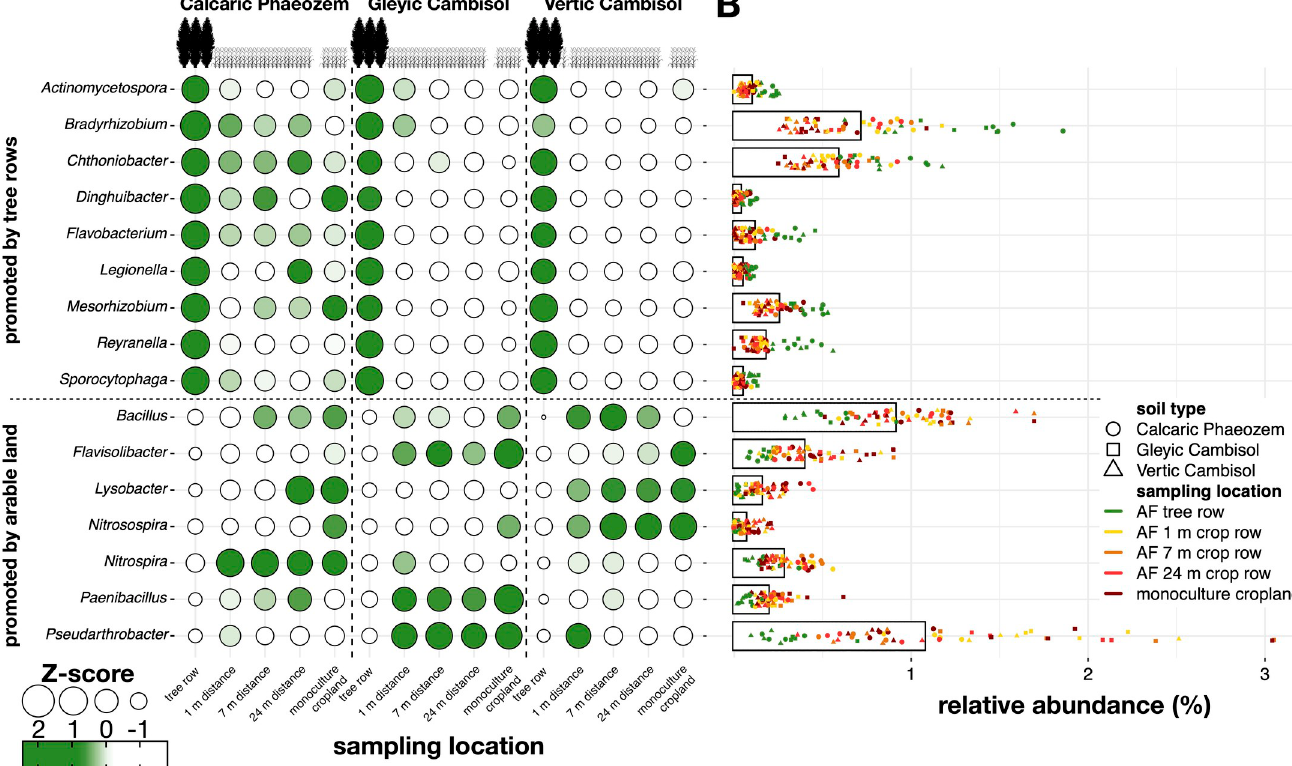
PLOS ONE | https://doi.org/10.1371/journal.pone.0246919 February 10,